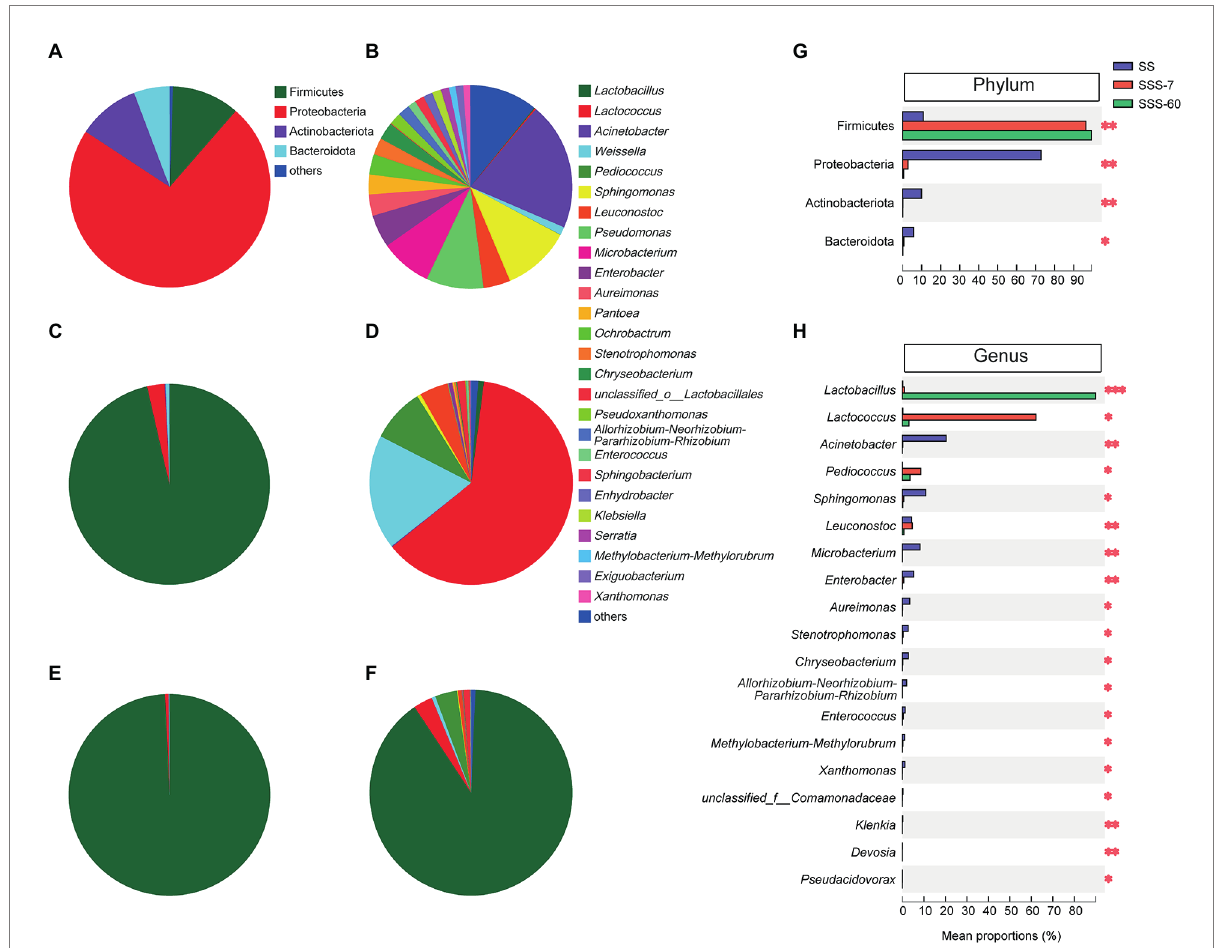
FIGURE 3 The pie plot of bacterial community at the phylum level in SS (A) , SSS-7 (C) , and SSS-60 (E) . The pie plot of bacterial community at the genus level in SS (B) , SSS-7 (D), and SSS-60 (F) . Multispecies difference test histogram of bacterial community at the phylum (G) and genus (H) level in SS and SSS. SS, high-moisture sweet sorghum; SSS, SS